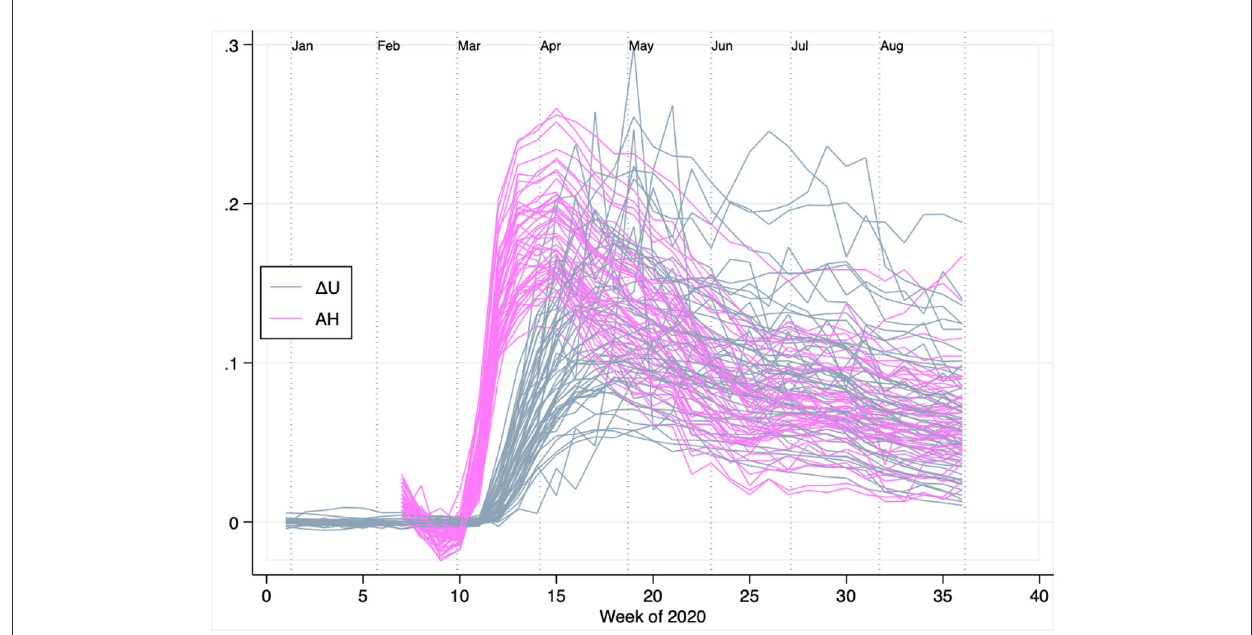
FIGURE1 Abnormally high unemployment and low mobility in the United States during the first 36 weeks of 2020. Each pink line represents a state’s year-to-year change in unemployment ( 1 U ) in 2020 vs. 2019. The flat pattern seen until the 12th week of 2020 (mid-March) indicates that, before shutdowns, unemployment rates across states were much like in the weeks of 2019. Each gray line represents abnormal stay-at-home rates, measured relative to the first six weeks of 2020. Consistent with a surge of unemployment fueled by mobility restrictions, the surge of stay-at-home rates precedes that of